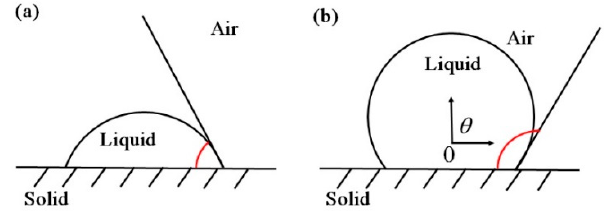
Figure 2. Static contact angel ( θ ) of droplet on solid surface: ( a ) droplet performs high wettability on solid surfaces; ( b ) droplet performs low wettability on solid surfaces.